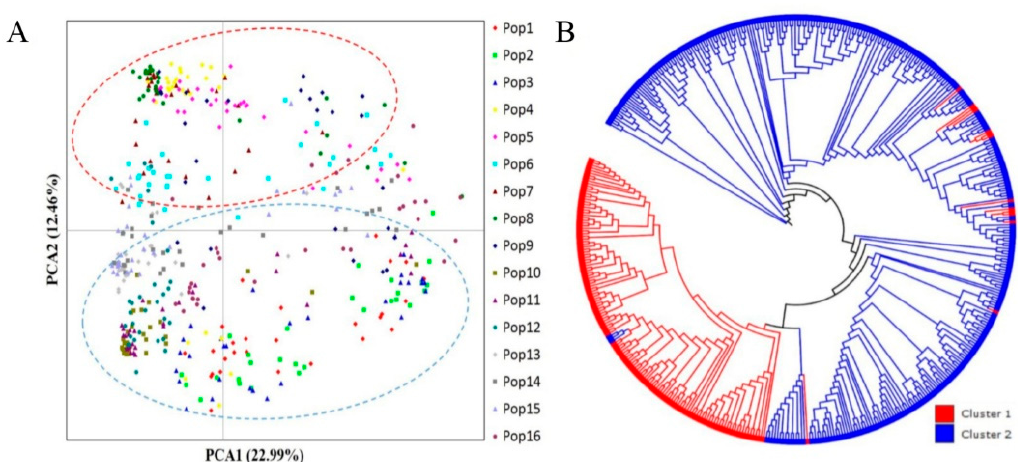
Figure 3. Genetic variation and relationships among the 16 sampled natural Pinus koraiensis populations in northeast China. ( A ) Principal coordinate analysis (PCA) based on pairwise genetic distance. ( B ) NJ dendrogram of 480 individuals based on Nei’s (1983) genetic distance.